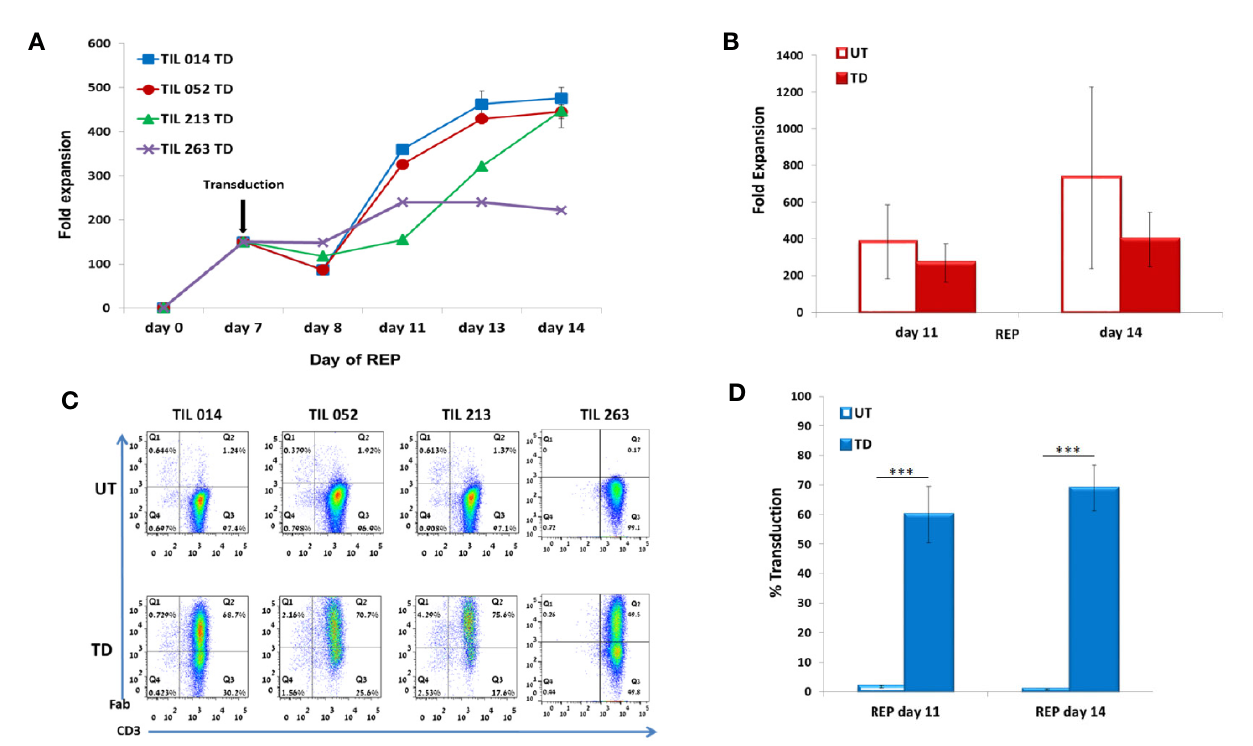
FIGURE 3 | Characterization of REP/d7-transduction protocol. TIL014, TIL052, TIL213, and TIL 263 cultures were transduced with the anti-CD19 CAR on day 7 of REP. (A) Fold expansion during REP. (B) Average fold expansion of transduced (TD) and untransduced (UD) TIL on days 11 and 14 of REP. (C) Transduction ef fi cacy as determined by fl ow cytometry analysis for the CD3+F(ab ′ )2+ expression; representative FACS histogram plot. (D) Average frequency of transduced cells on days 11 and 14 of REP. ***p <